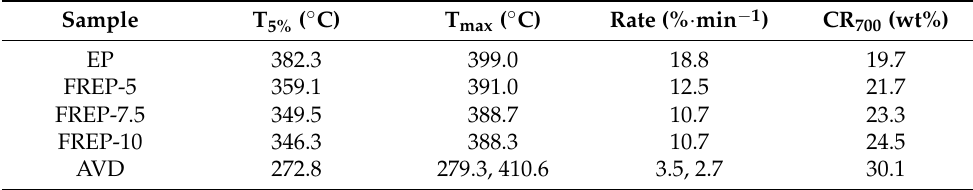
Figure 4. TG ( a ) and DTG ( b ) curves of AVD and epoxy thermosets in nitrogen. Table 3. Thermal stability parameters of EP and FREPs.